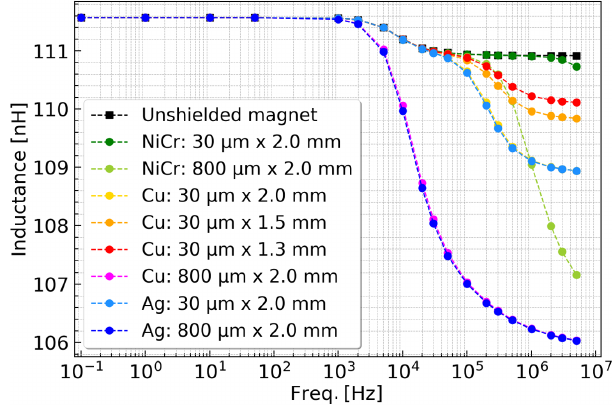
FIG. 14. Inductance of a central cell, excluding internal induct- ance of busbars, as a function of frequency for the FCC-hh injection kicker magnet with a beam screen, analyzed for different materials, width and thickness of the screen